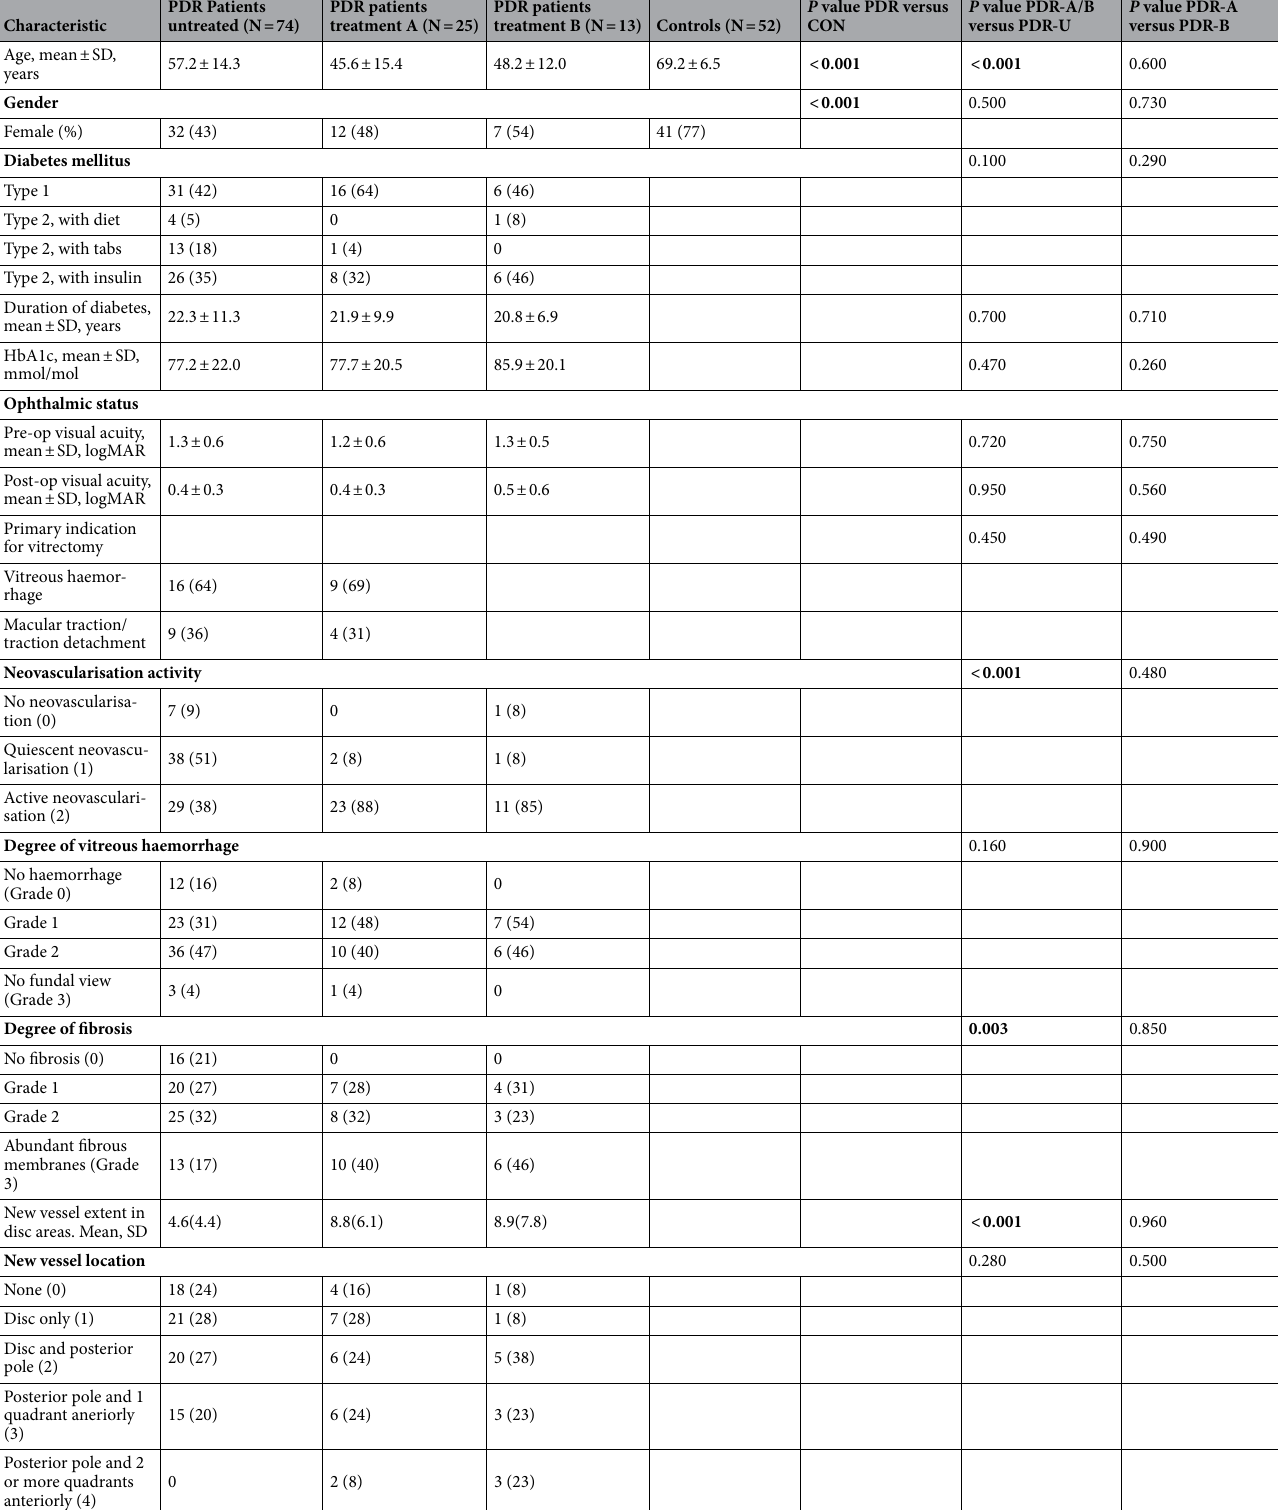
Table 1. Patient characteristics. All values given as number (percentage) unless stated. PDR Proliferative diabetic retinopathy, PVR Proliferative vitreoretinopathy, PDR-U Untreated PDR patients, PDR-A PDR patients pre-operative treated with aflibercept, PDR-B PDR patients pre-operative treated with bevacizumab or ranibizumab, SD Standard deviation. P values < 0.05 are given, P values > 0.05 are indicated as "-". P values < 0.01 are considered to be statistically significant and are indicated in